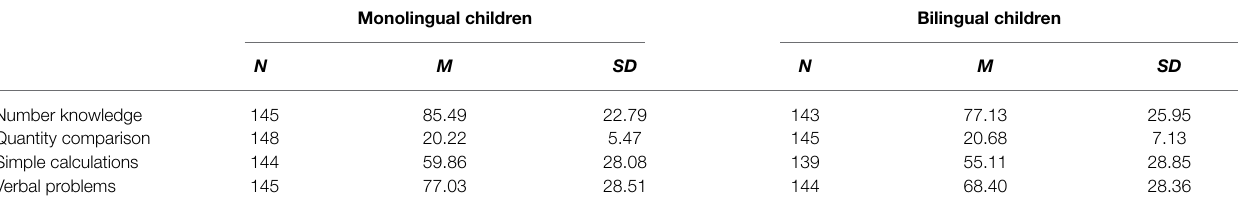
TABLE 4 | Means and SD of the different early numeracy factors among the different groups of